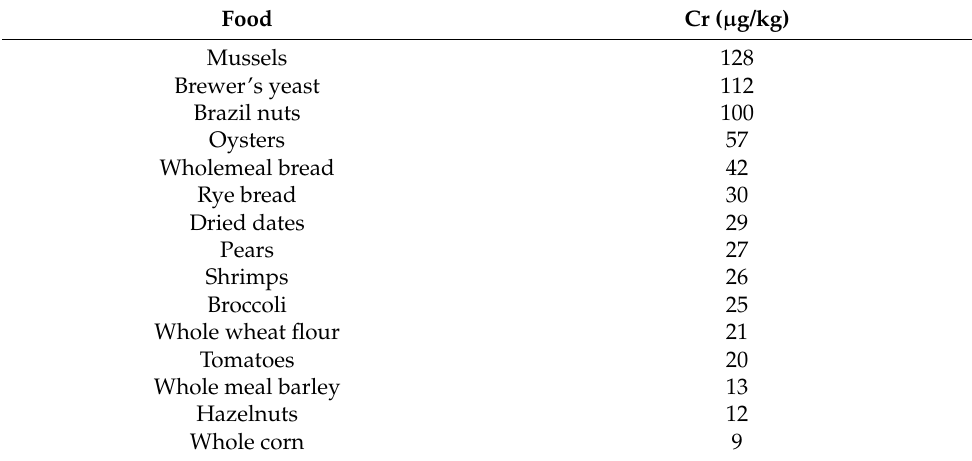
Table 3. Food sources of